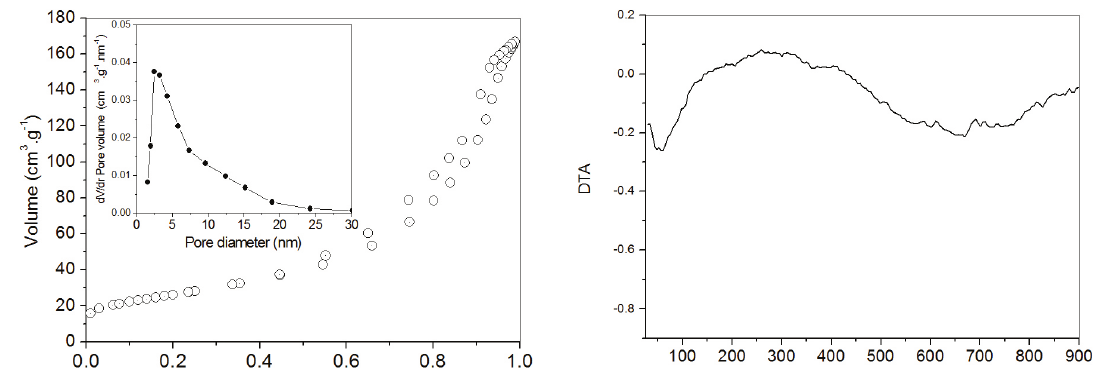
Figure 3. N diameter distribution of ZnAl